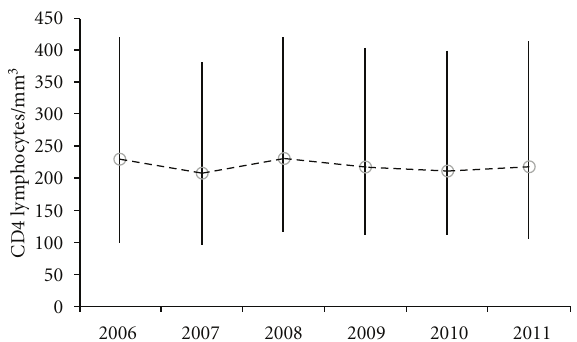
Figure 3: Median and interquartile range of CD4 lymphocyte count at HIV presentation by calendar year of